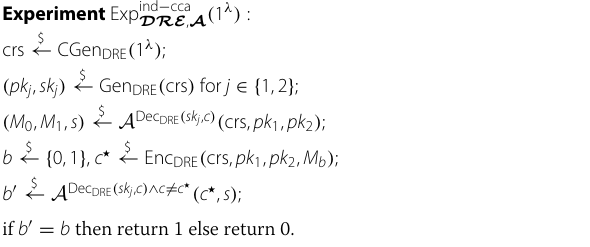
Table 3 IND-CCA security for DRE Experiment Exp ind − cca DRE